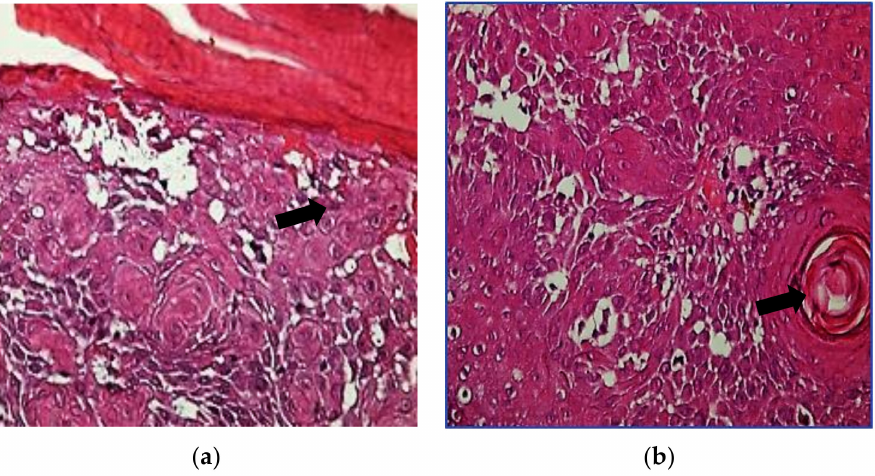
Figure 1. Keratoacanthoma. HE (40 × ) ( a ) acanthosis; ( b ) horny plugs, pseudoepitheliomatous